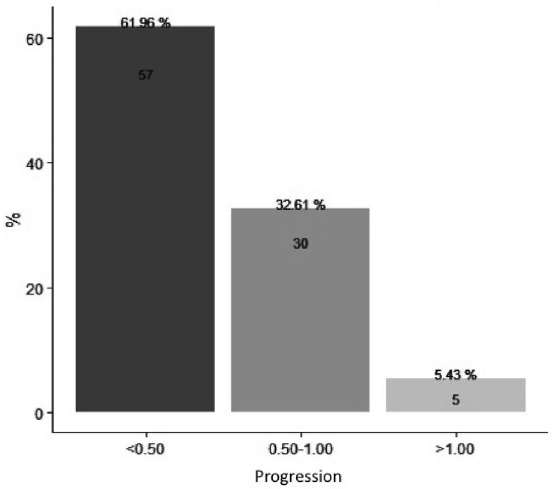
Figure 2. Patients distribution of the spherical equivalent progression during follow-up period.